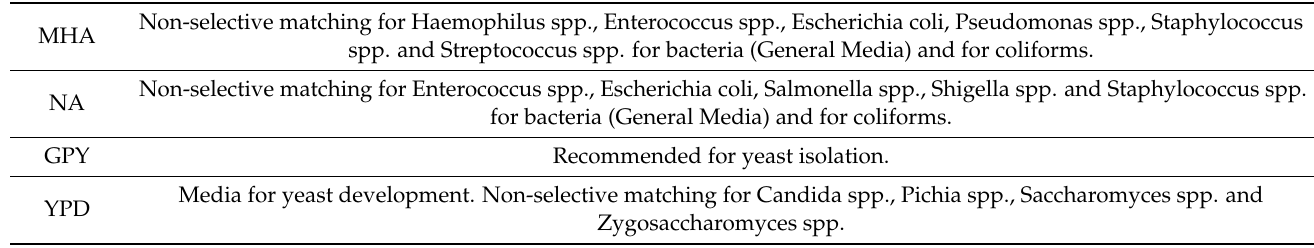
Table 1. Culture media and specific properties.